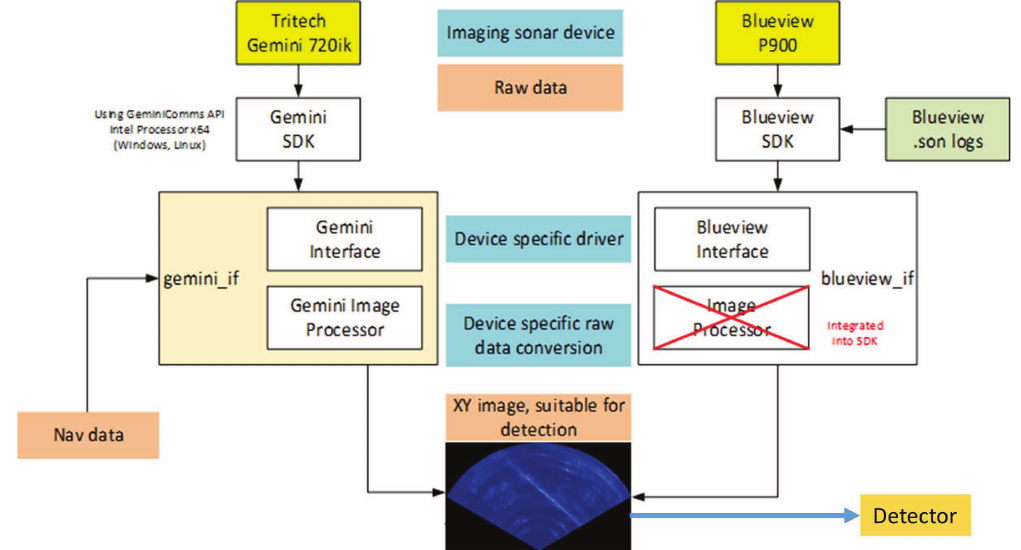
Figure 3. Workflow for obtaining XY-images from raw sonar data independent of the sonar